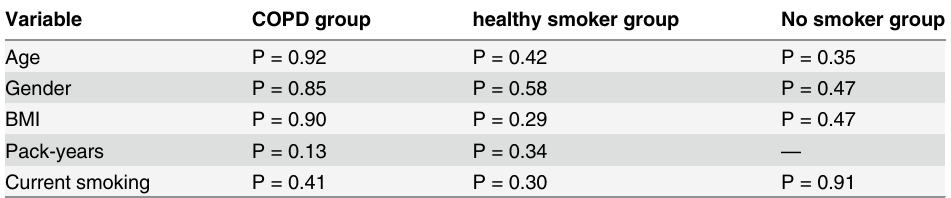
Table 2. Relative mitochondria DNA copy number related to variables in COPD group, healthy smoker group and no smoker group respectively.